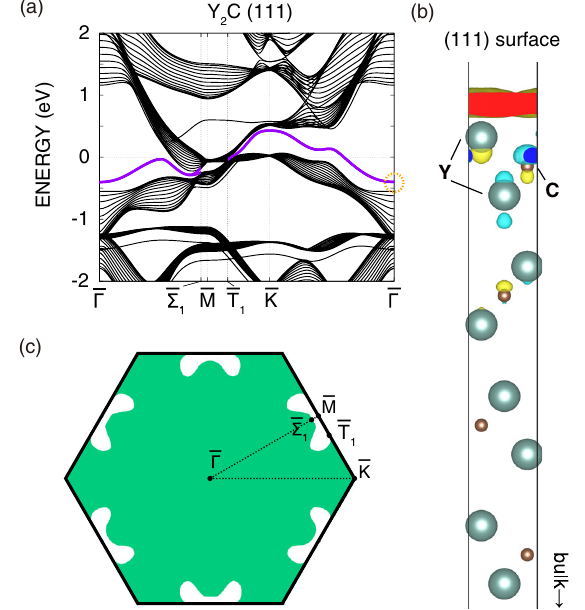
FIG. 2. Floating topological surface states in Y 2 C. (a) Electronic band structure of the slab of Y 2 C with surfaces along (111) ¯ Γ ¼ ð 0 ; 0 ; 0 Þ ¯ in the GGA. The symmetry points are ; X ¼ ð π = 2¯ a Þð 0 . 5 ; 0 . 5 ; 0 Þ ; and ¯ K ¼ ð π = 2¯ a Þð 1 ; 0 ; 0 Þ , where ¯ a is the lattice constant for the surface. The energy is measured from the Fermi level. The purple band represents the topological surface states extending from the nodal line near the Fermi level. (b) Charge distribution of the drumhead surface state at the Γ point. The corresponding point is indicated by the dotted circle in (a). The yellow and light blue represent the positive and negative components of the wave function, respectively, and the red and navy blue represent their cross sections, respectively. (c) Depend- ence of the Zak phase on the surface momentum k k . The shaded region represents k k with the π Zak phase, while other regions represent that with the 0 Zak